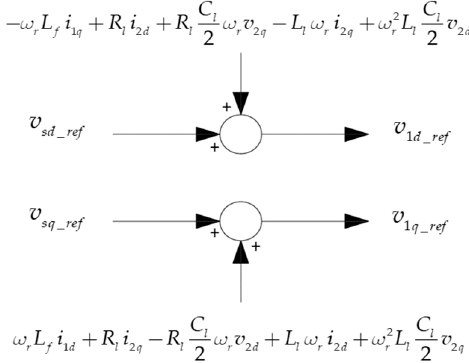
Figure 9. Filter and Line compensation terms.